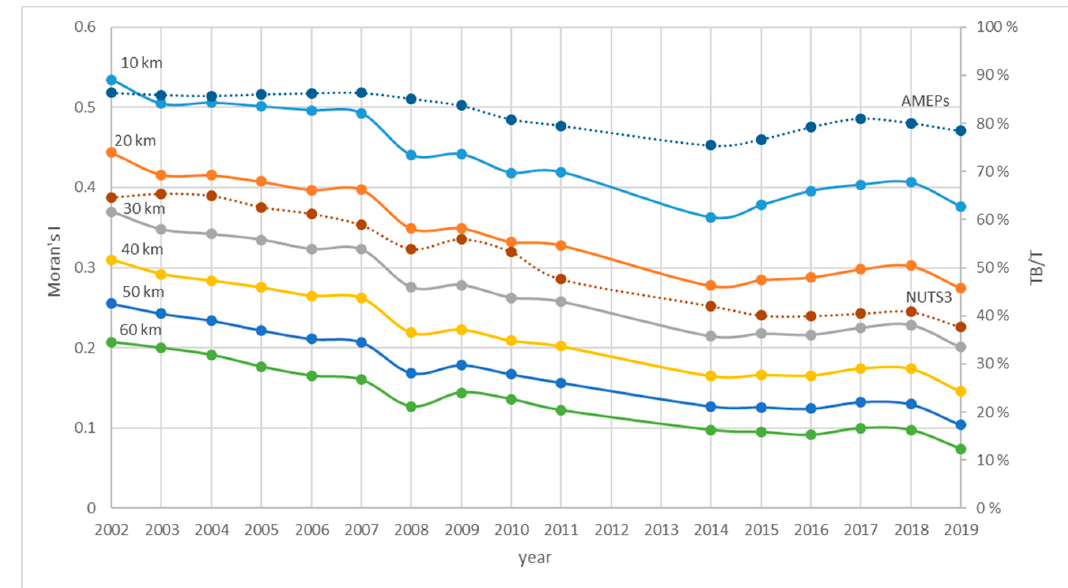
Figure 2. Theil index decomposition and Moran’s I with 10–60 km distance-based spatial weights; unemployment between 2002 and 2019 in Czechia (municipal level). Note: Existing administrative divisions: districts (NUTS 3 = 14 units) and areas of municipalities with extended powers (AMEPs = 206 units).